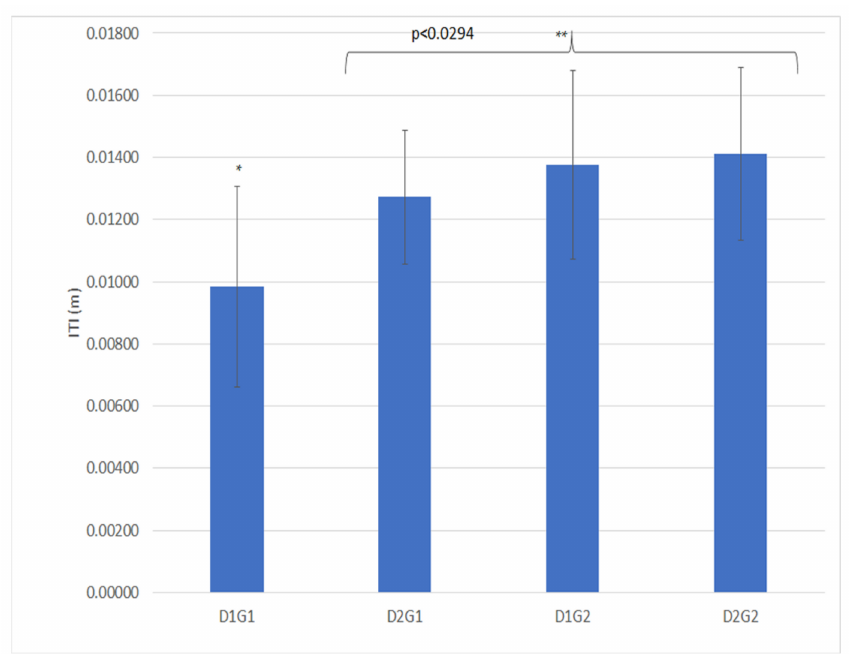
Figure 8. Double interaction of the drainage and geotextile for ITD (m). D1: no drainage; D2: drainage package; G1: without geotextile; G2: with 2 kg/m 2 of geotextile. The stars (*, **) indicate significative